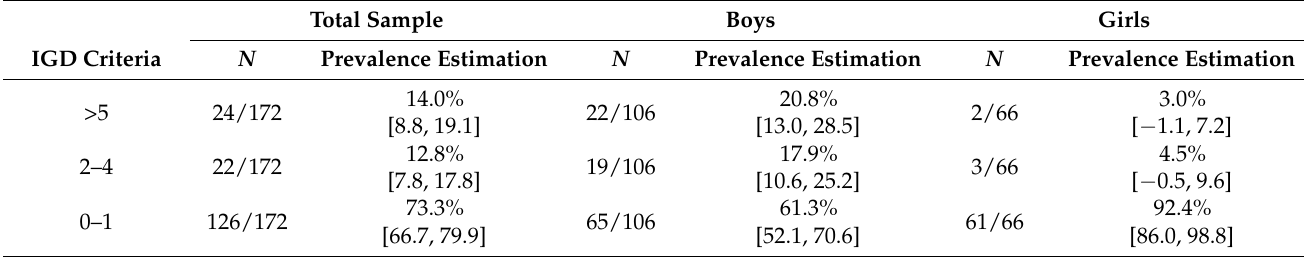
Table 2. Estimated IGD prevalence in 11- to 17-year-old patients in outpatient psychotherapy assessed via parental report. Total Sample